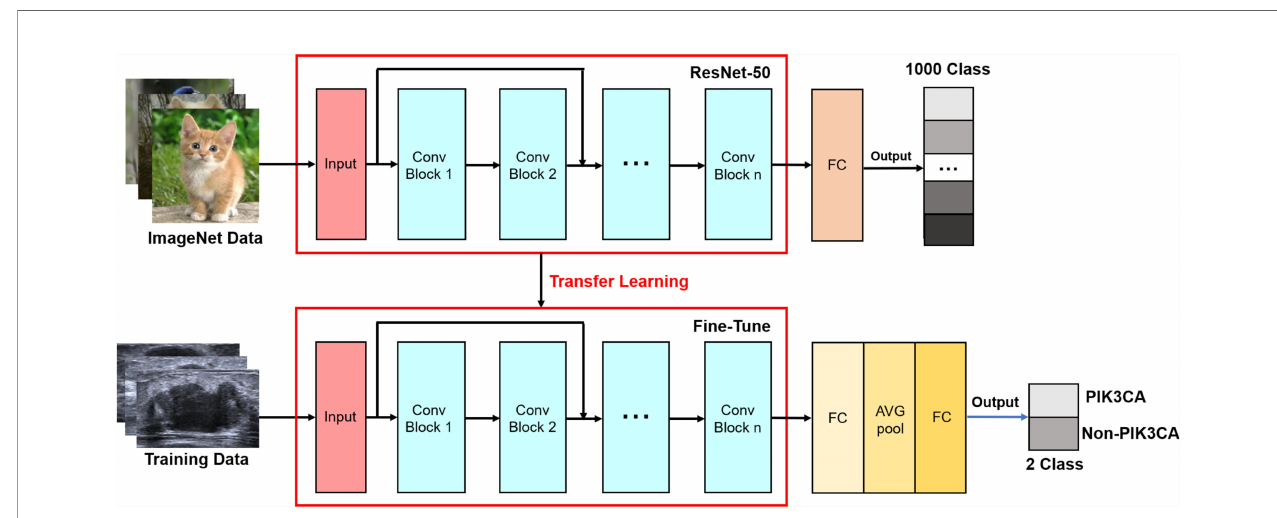
FIGURE 3 | The ImResNet model ’ s structure